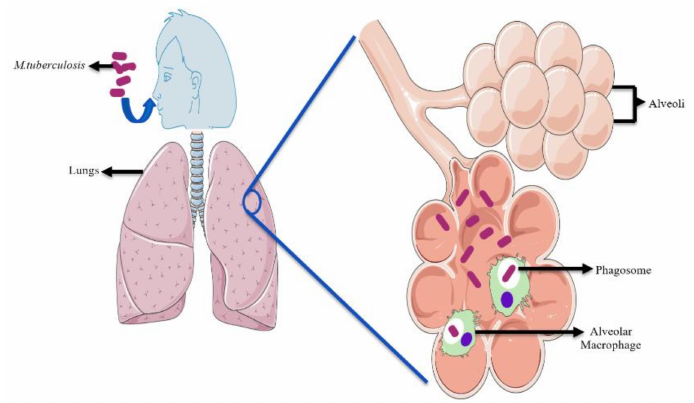
Figure 1. M. tuberculosis entry and presentation in